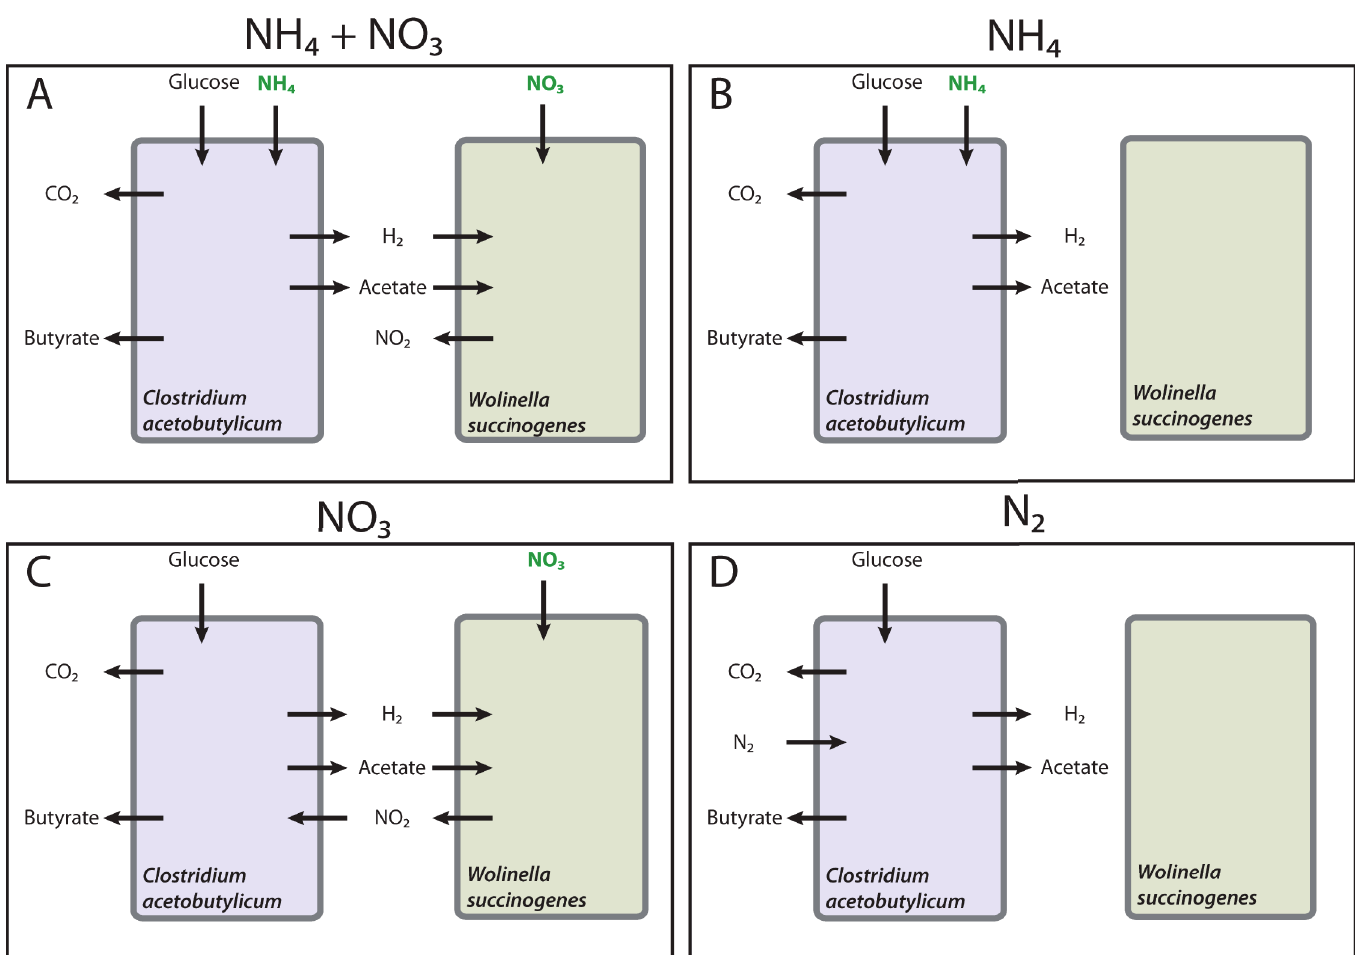
Fig 1. Source of nitrogen is expected to influence the metabolic interactions between C. acetobutylicum and W. succinogenes . A shows the expectedinteractions between C. acetobutylicum and W. succinogenes in the presenceof NH 4+ and NO 3- . B shows the interactionsin the presenceof only NH 4+ , C in the presenceof only NO 3- and D shows the expectedinteractions in the presenceof only N 2 . Although we expect certain interactionsin the co- culture duringthe variousenvironmental conditions, we do not know at what rate the metabolites are